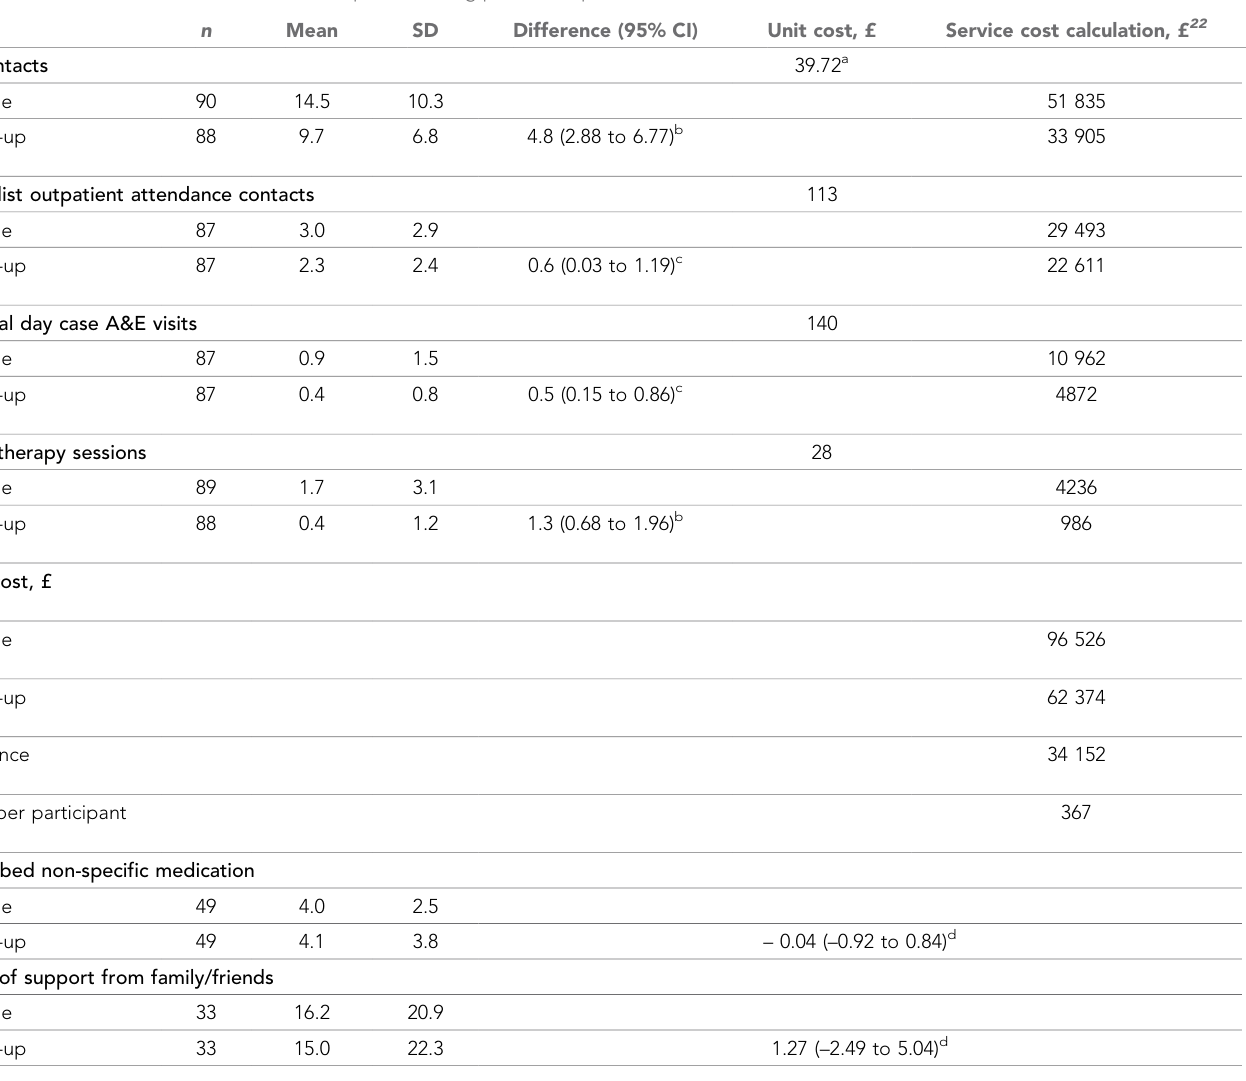
Table 3. Service utilisation and cost data comparison, using paired samples t